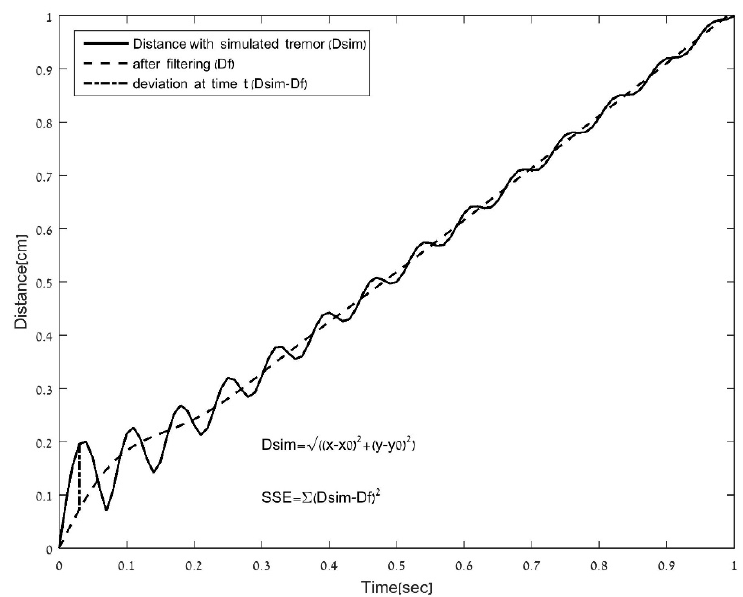
Figure 4. A 1 cm window of the distance (data point to the initial point) of a simulated vertical line with a tremor of 7 Hz and a 4 Hz cut-off filtered signal. Deviation of the distance curve from a curve after filtering was computed as the normalized sum of square deviations of all points (line outcome measure b).